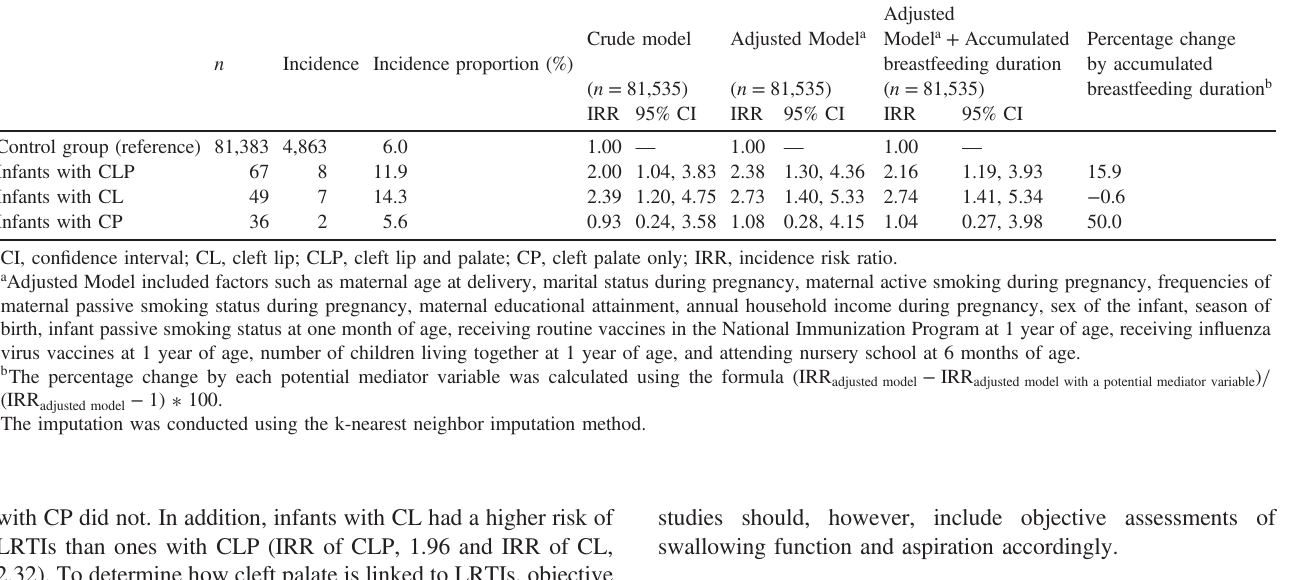
Table 2. Associations between orofacial cleft status and lower respiratory tract infections after imputation